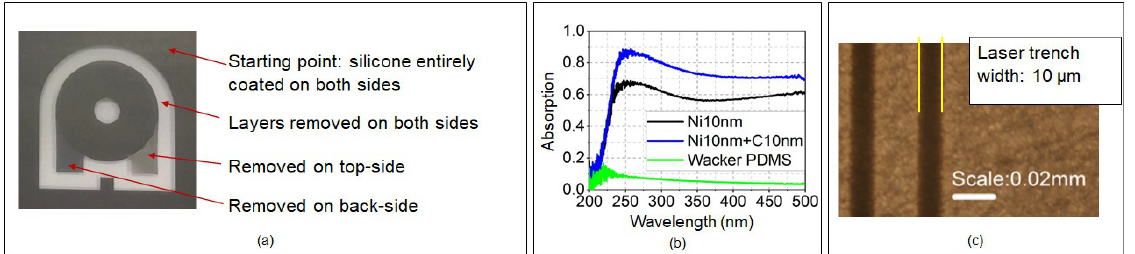
Figure 8. Simultaneous two-side electrode structuring technique ( a ), based on optimal absorption properties ( b ), high resolution suitable for future MEMS applications ( c ).